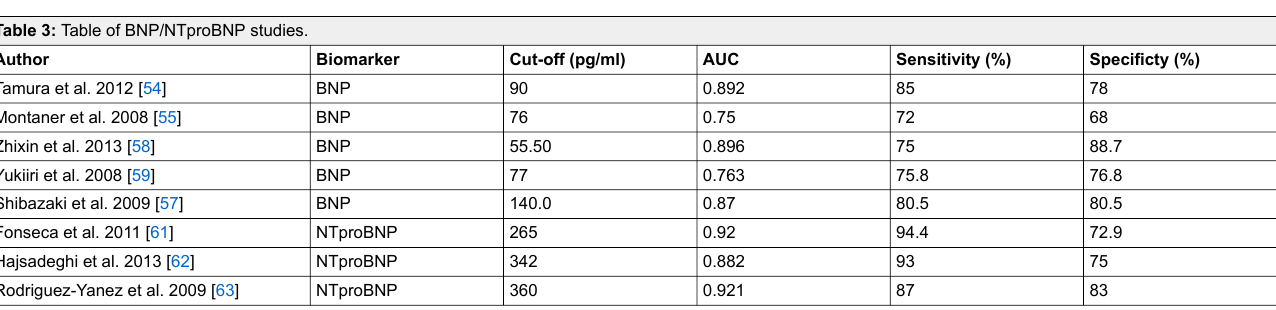
Table 3: Table of BNP/NTproBNP